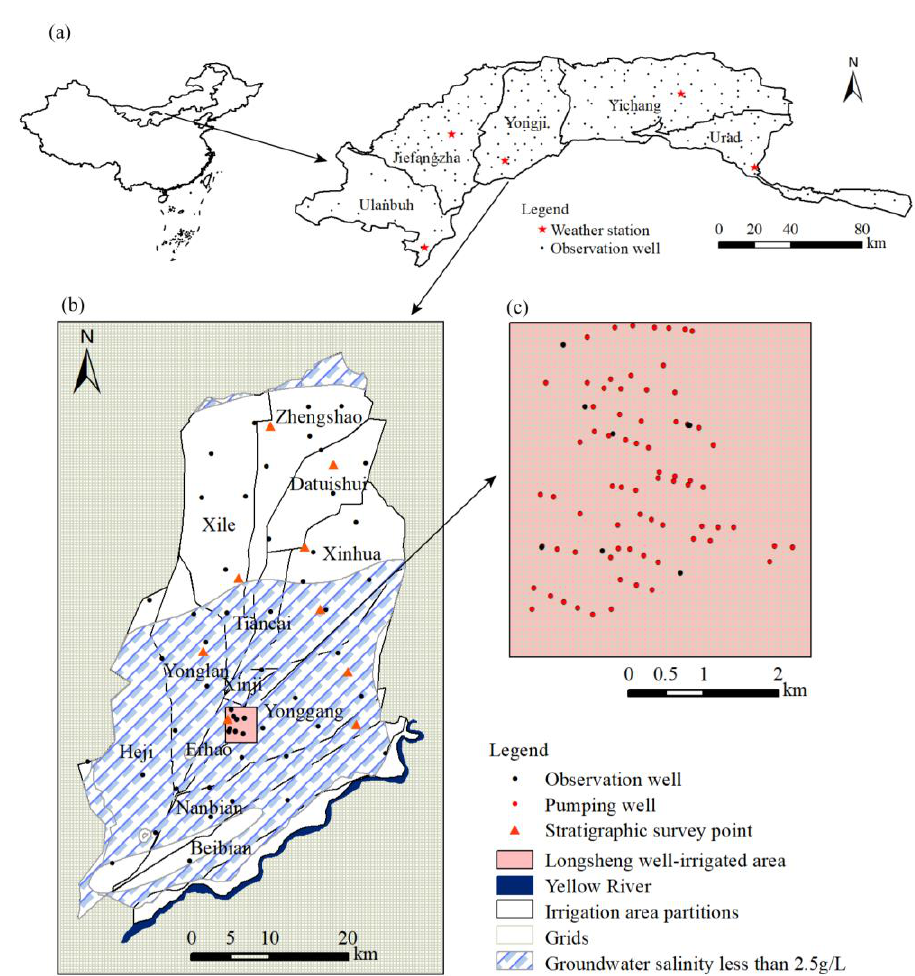
Figure 1. Geographic location of ( a ) Hetao Irrigation District, ( b ) Yongji sub-irrigation district and ( c ) Longsheng well-irrigated area.